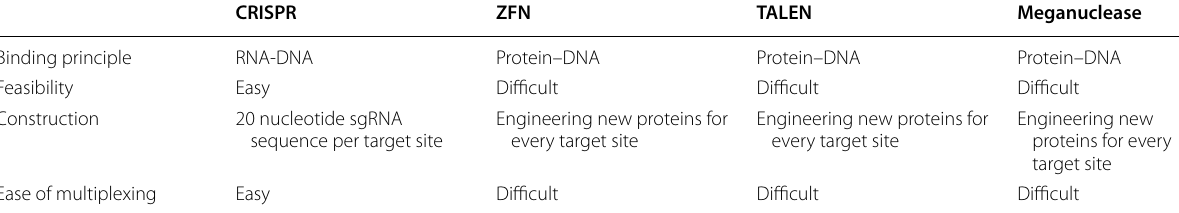
Table 1 Summary of characteristics of different gene editing